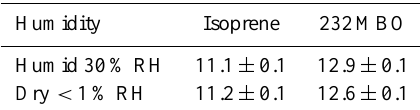
Table 1. Normalized sensitivities in ncpsppbv − 1 (: = 1 × 10 6 ×